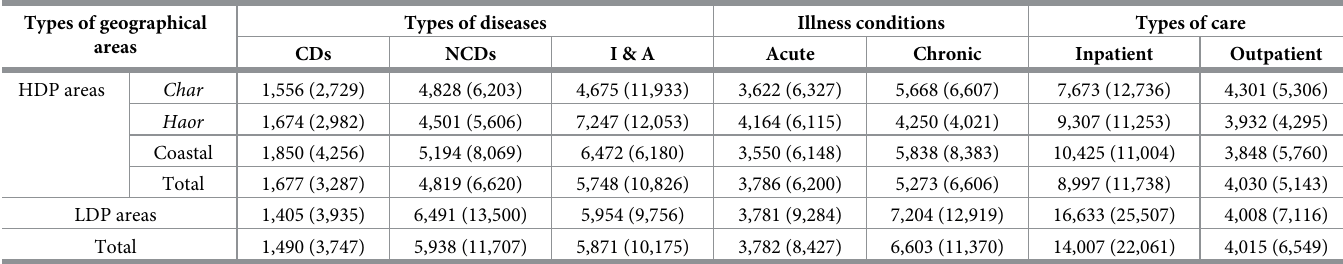
Table 3. Out-of -pocket payments by types of illnesses, types of care and geographical areas. Types of geographical